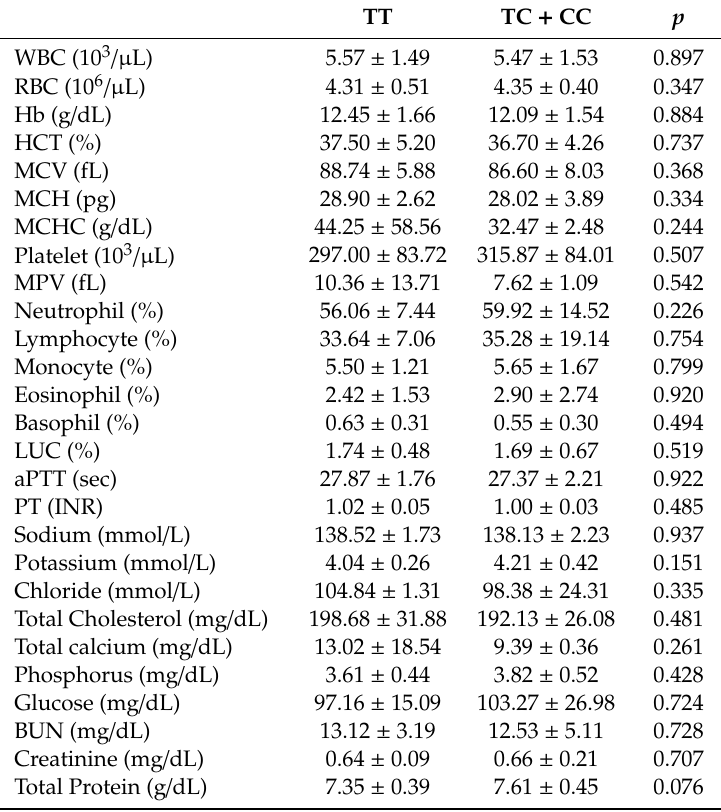
Figure 2. Values of thyroid functional markers (T3, TSH, and fT4) in TT and TC + CC genotypes of rs2239359 in FANCA. Table 4. Association of rs2239359 genotype in FANCA with blood parameters in subjects with leiomyomas.